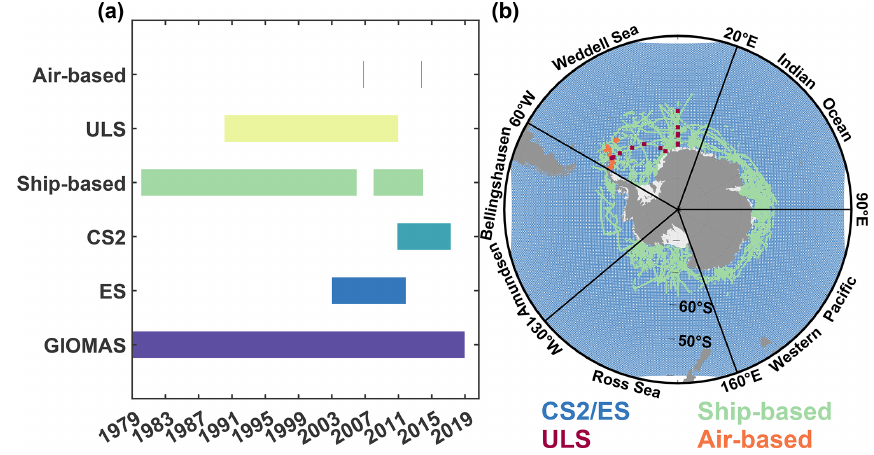
Figure 1. (a) The temporal and (b) spatial coverage of data used in this study.